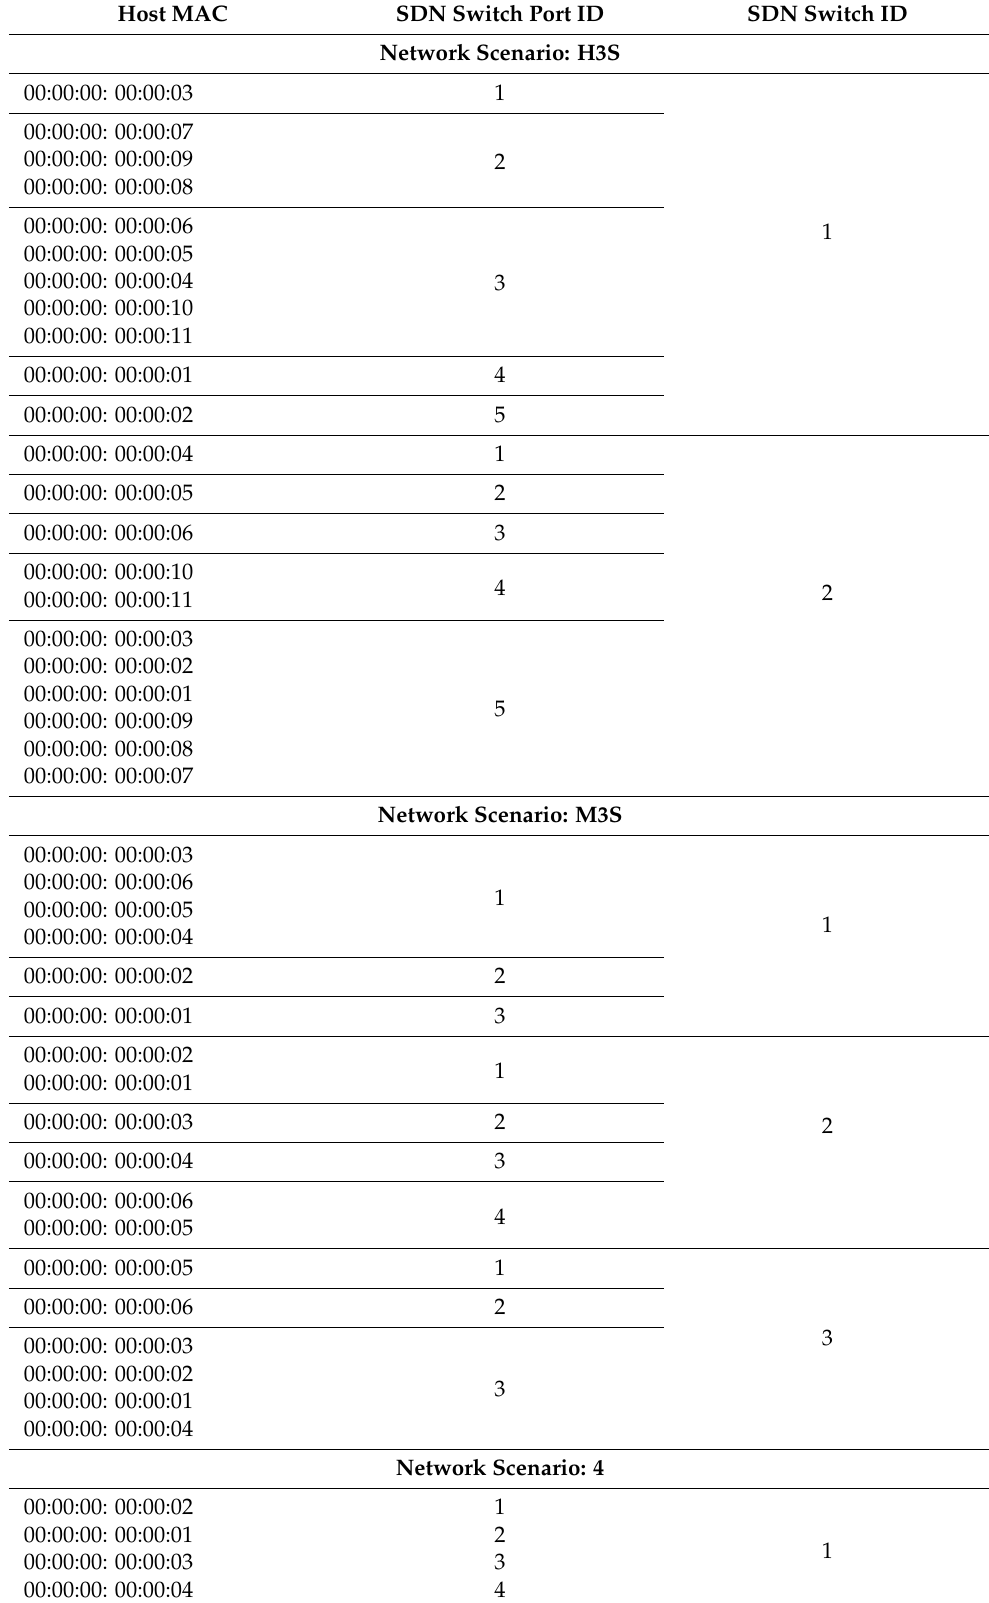
Table 1. HostLink Table